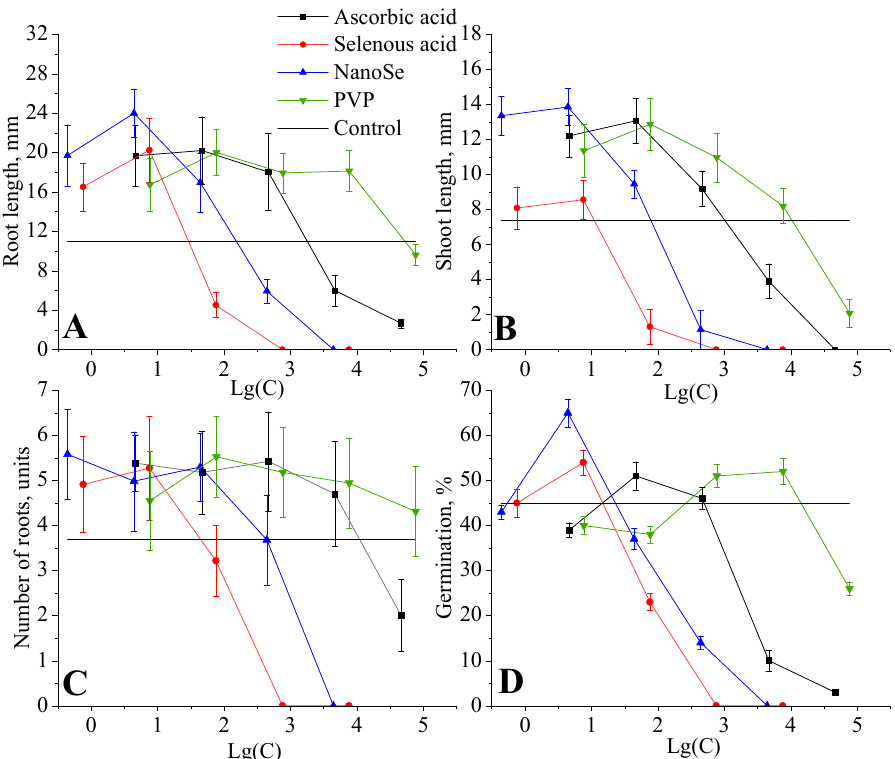
Figure 4. Dependencies of morphological and functional characteristics of the treated seeds on the concentration of dressing agents (72 h incubation): ( A ) dependencies of the root length on the logarithm of the seed dressing agents’ concentrations; ( B ) dependencies of the shoot length on the logarithm of the seed dressing agents’ concentrations, ( C ) dependencies of the number of roots on the logarithm of the seed dressing agents’ concentrations, ( D ) dependencies of germination percentage on the logarithm of seed dressing agents’ concentrations ( p < 0.05).